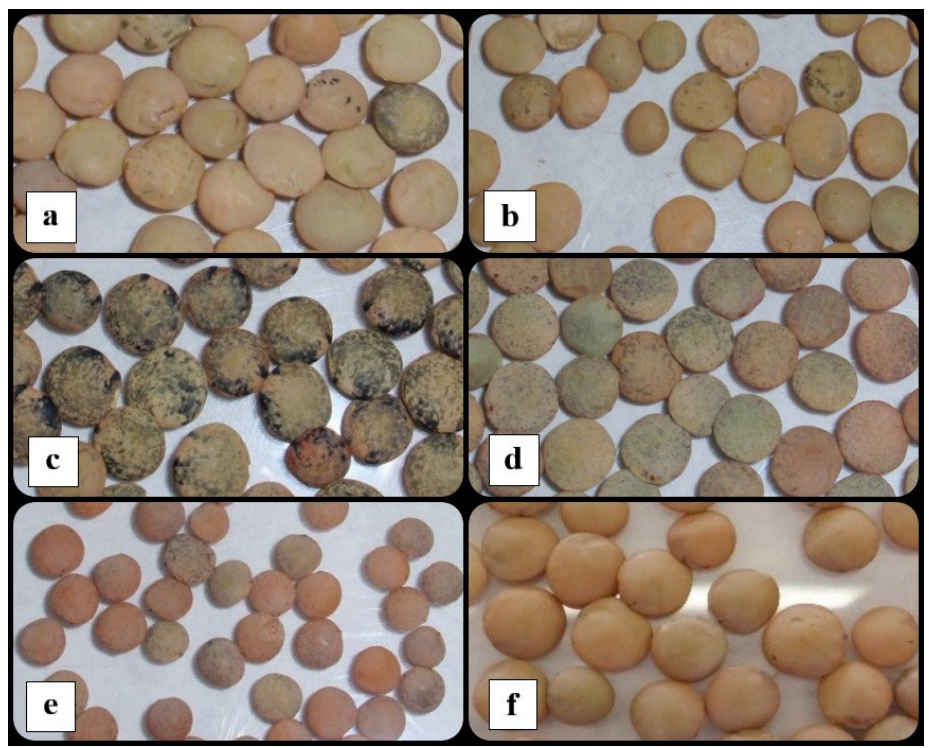
Figure 1. The lentil cultivars used in this work: ( a ) Guareña; ( b ) Rubia de la Armuña; ( c ) Jaspeada; ( d ) Microjaspeada; ( e ) Pardina; ( f ) Rubia